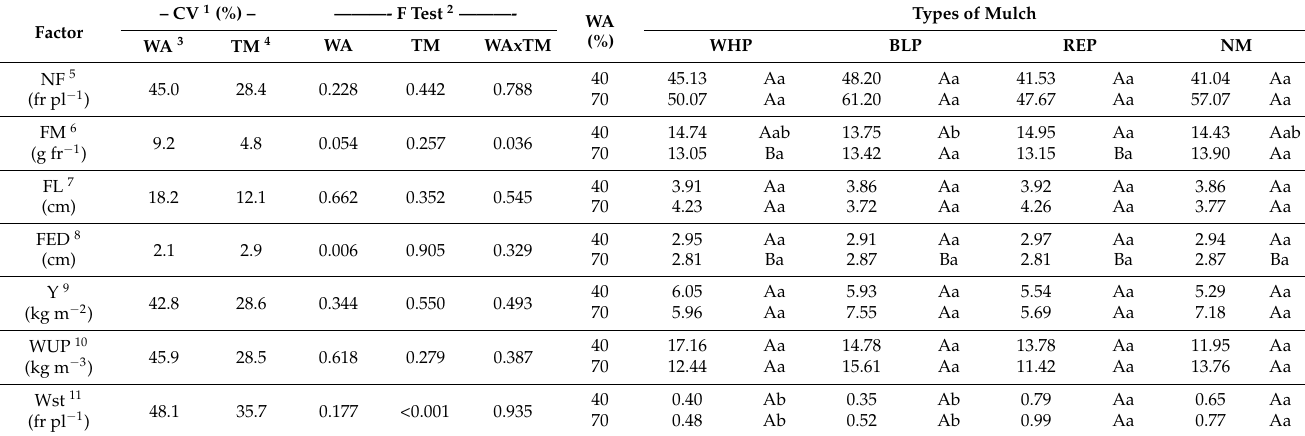
Table 5. Agronomic characteristics of strawberries as a function of wetted areas and types of